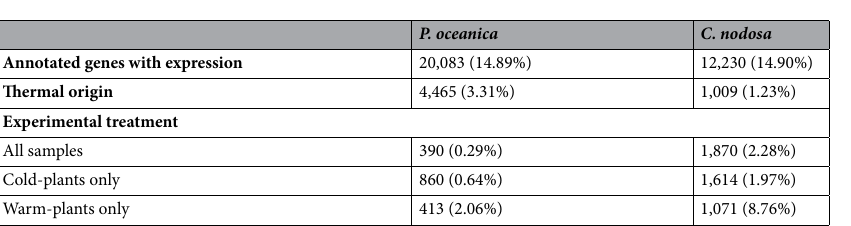
Table 2. Number of differentially expressed genes (FDR < 0.05) in response to thermal origin of plants (warm- plants vs cold-plants), experimental treatment (i.e. warming; controls vs heated) and population-specific response to experimental warming (controls vs heated of cold- and warm-plants, separately). In parenthesis is shown the percentage that the number DEGs represent against the total number of genes of each species’